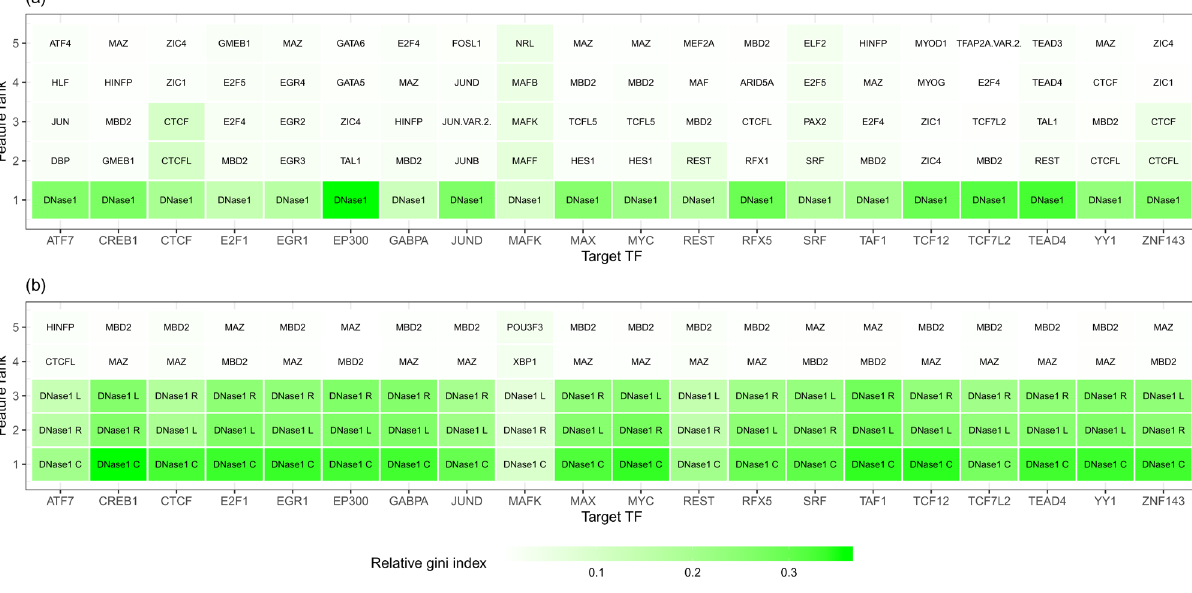
Figure 7. Top 5 features obtained from the average importance ranking of all tissue-specific classifiers for a given target TF shown on the x- axis for the peak setup ( a ) and the bin setup ( b ). Features related to DNase1 are the dominant ones.